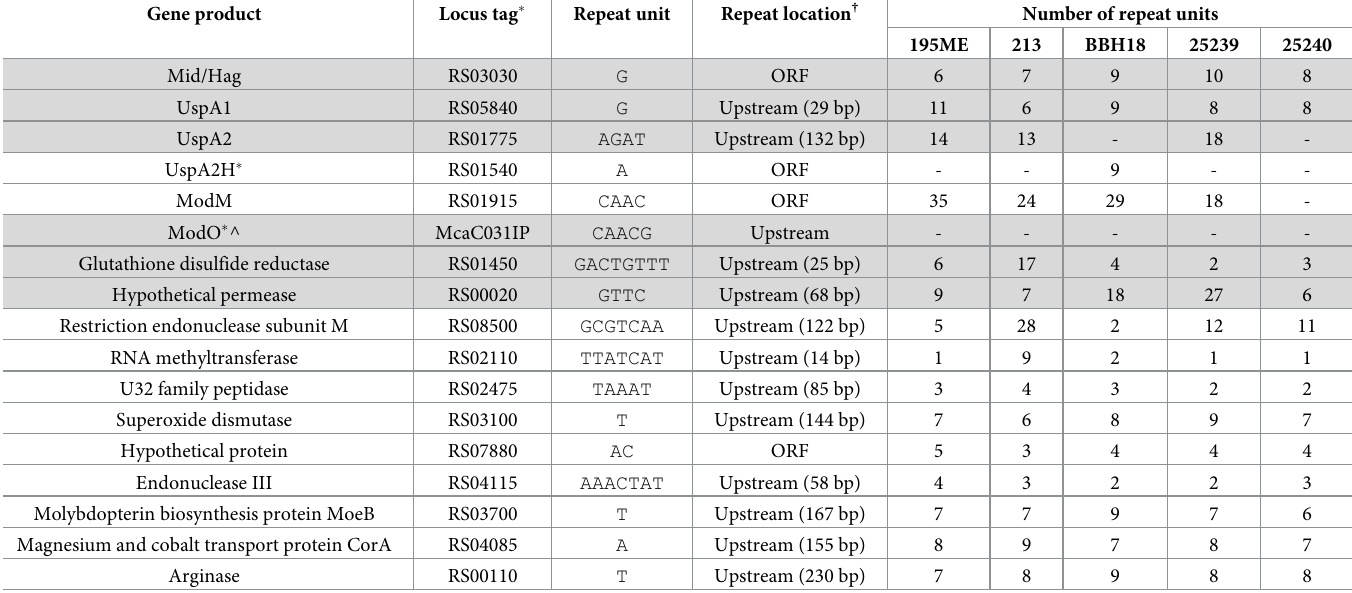
Table 1. Bioinformatic identification of genes with simple sequences repeats in Moraxella catarrhalis . Gene